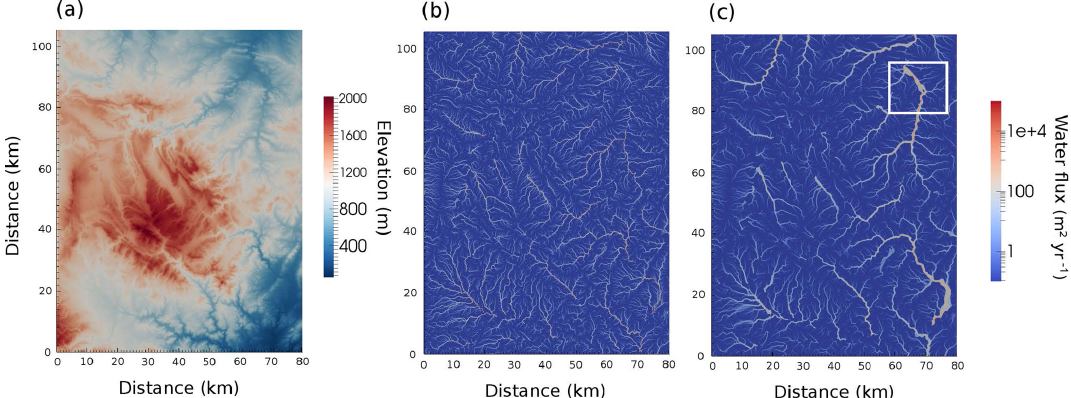
Figure 9. Application of the cell-to-cell SFD and node-node MFD algorithms to a palaeo-DEM (digital elevation model). (a) Palaeo-DEM created from ASTER data of the Ebro region of Spain. (b) Water flux after 20kyr of model evolution assuming an SFD with a model resolution of 1024 × 1024 cells. Uplift is assumed to be very small at 10 − 5 myr − 1 , with a precipitation rate held constant at 0 . 1myr − 1 . (c) Water flux for after 20kyr for a model assuming the node-to-node MFD routing. The white box in the top right highlights a region of the Riu Bergantes catchment where the river is known to have shifted course during the Holocene.